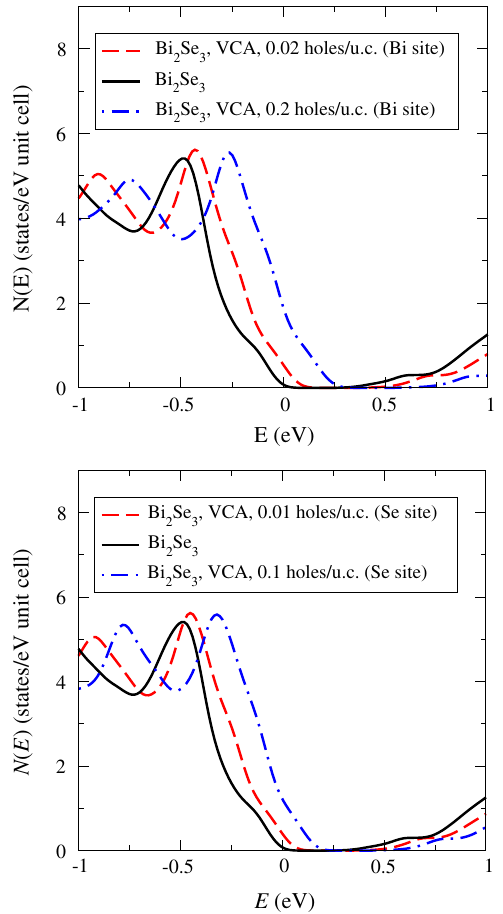
FIG. 6. Shown are the effects on the calculated Bi 2 Se 3 density- of-states of doping on the Bi site (top), and Se site (bottom), for the indicated doping levels within the virtual crystal approxima- tion. In both cases the valence band maximum of Bi 2 Se 3 is set to the energy